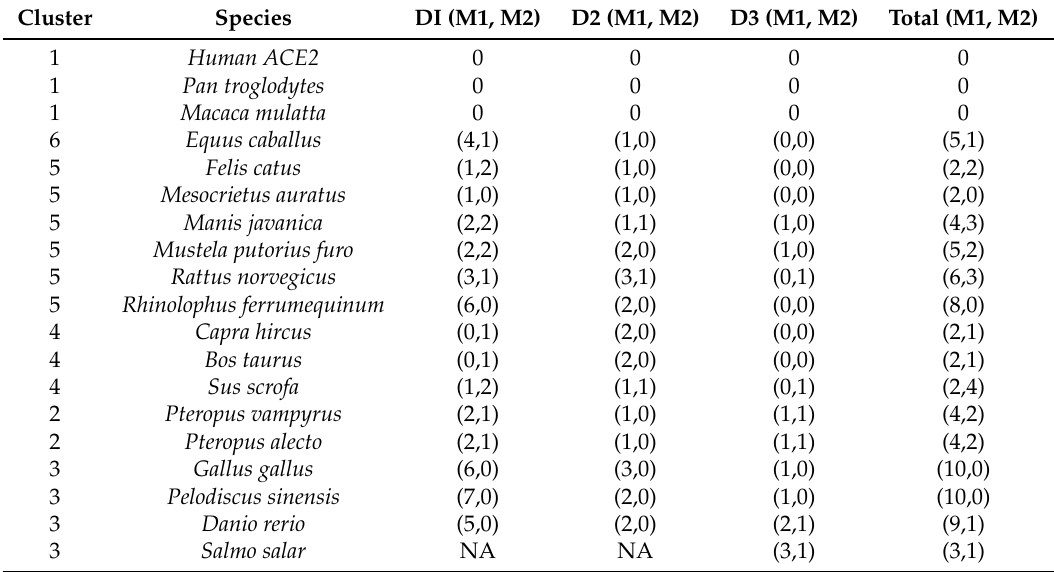
Table 1. M1 and M2 substitutions across nineteen ACE2